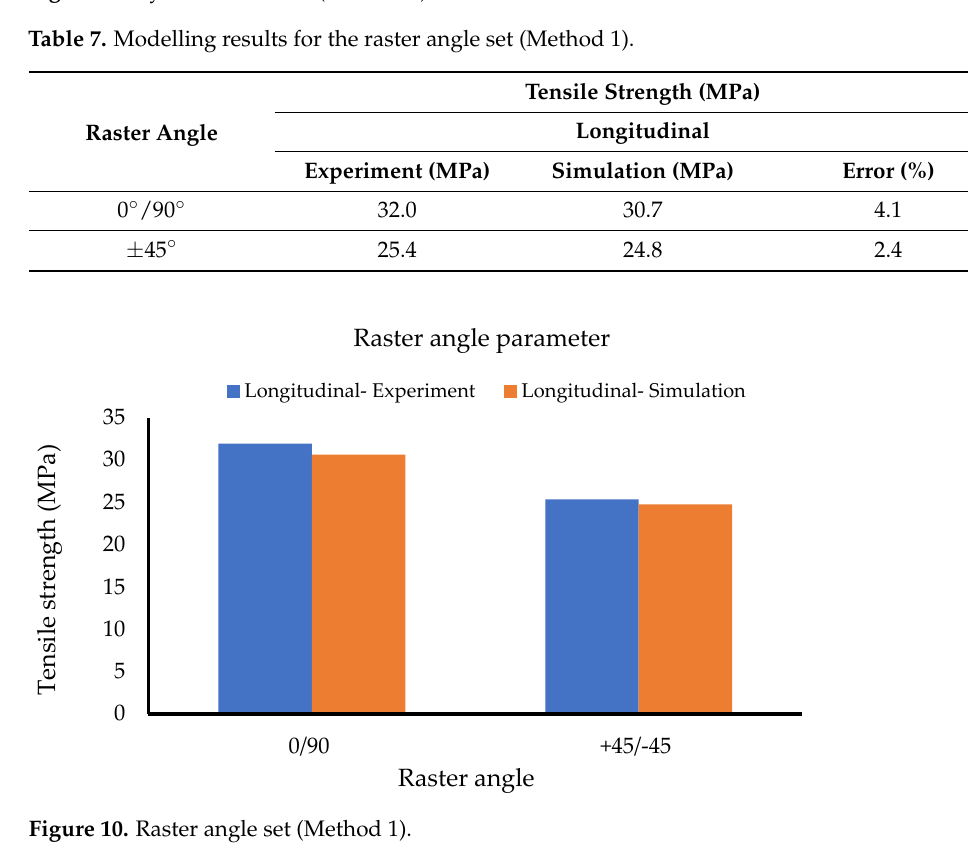
Table 8. Modelling results for the temperature set (Method 1). Temperature (°C)